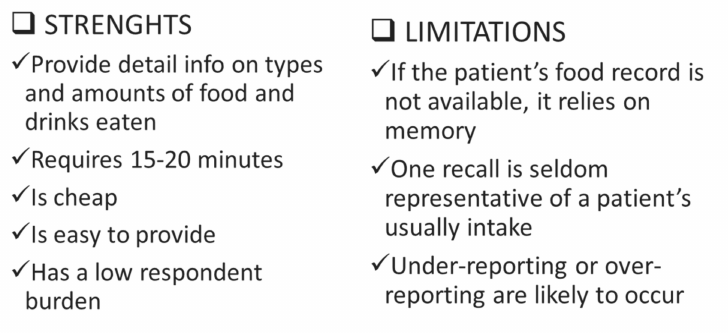
Figure 2. Oral food intake by 24-h food